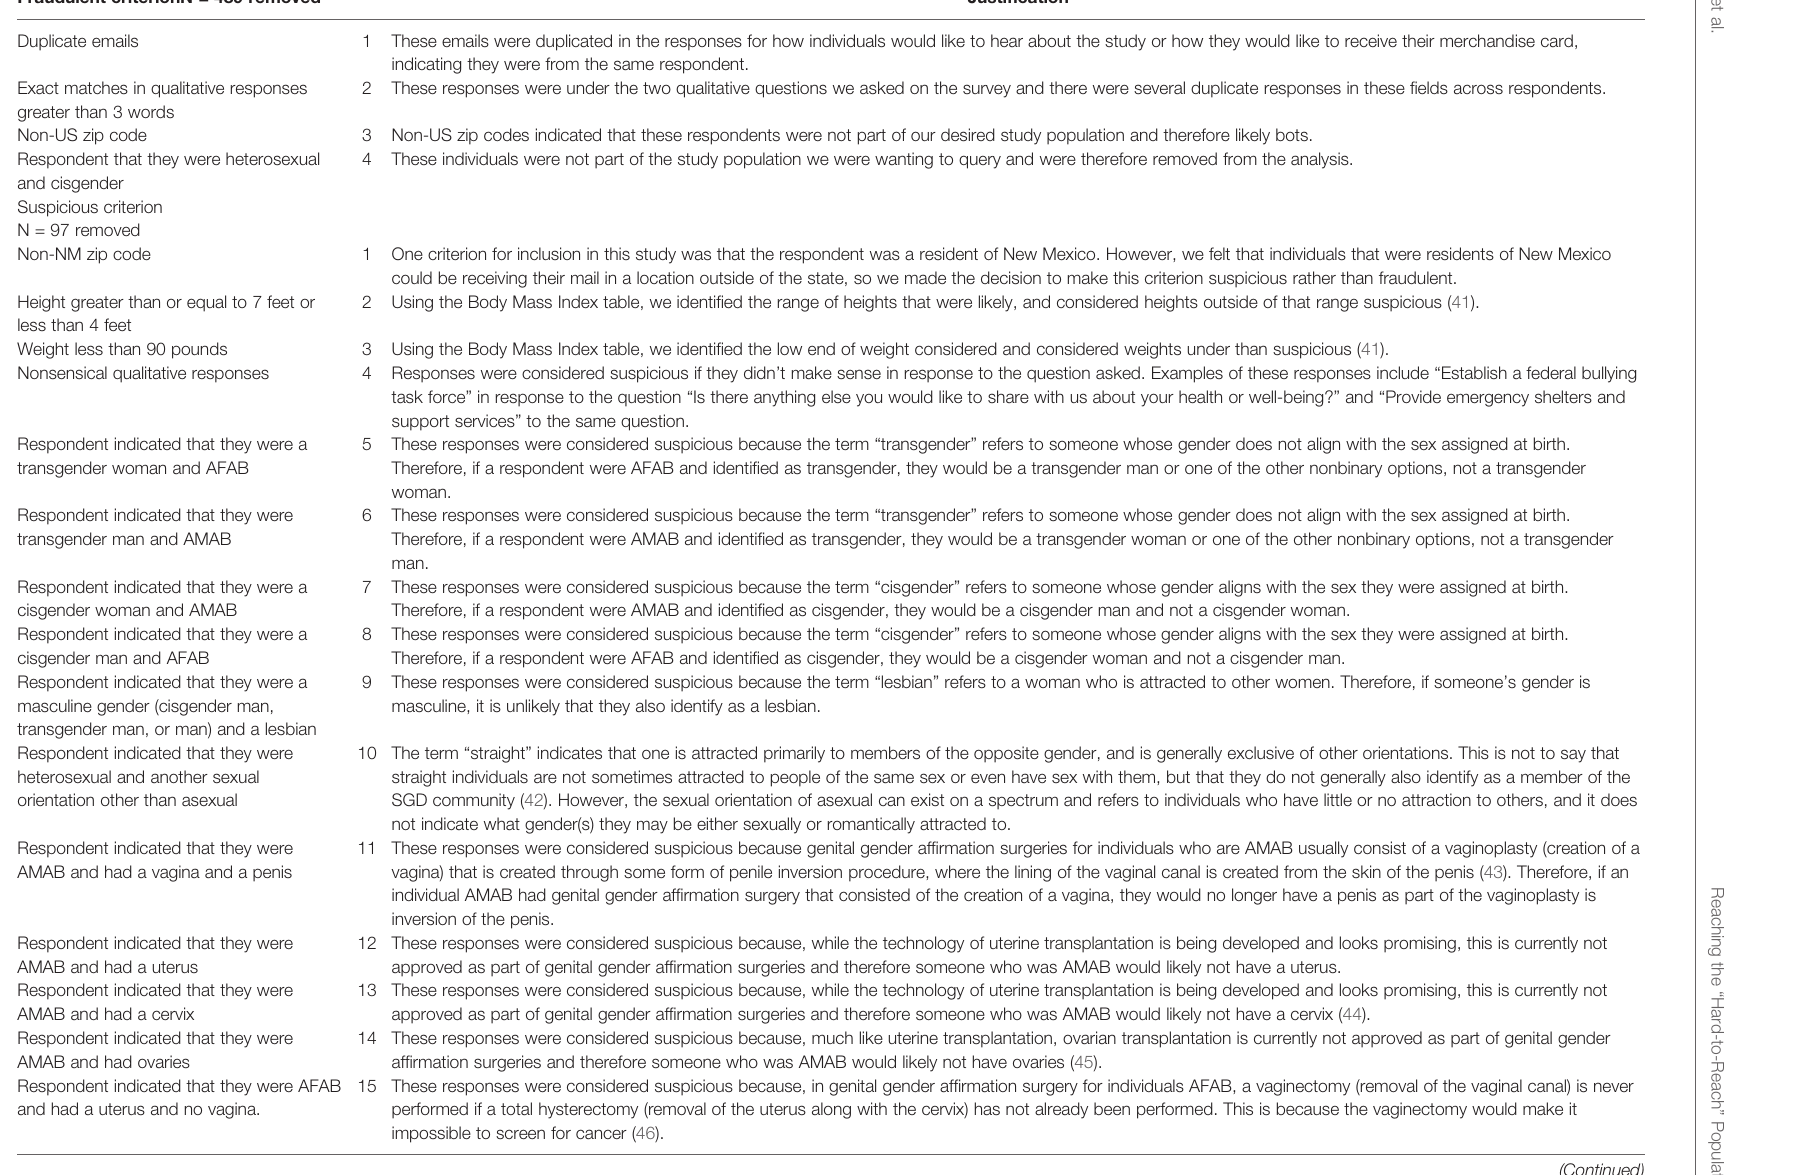
TABLE 1 | Fraudulent and suspicious criteria applied to ensure data